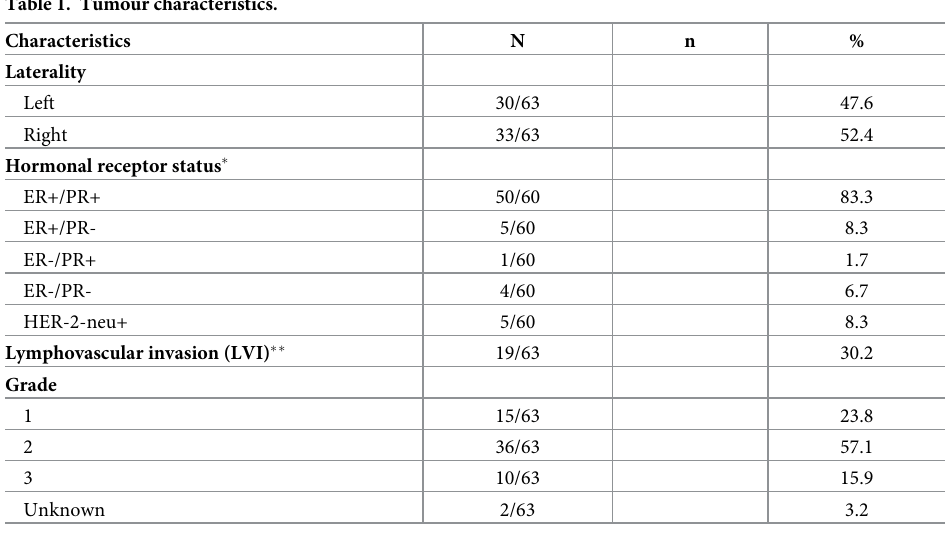
Table 1. Tumour characteristics.